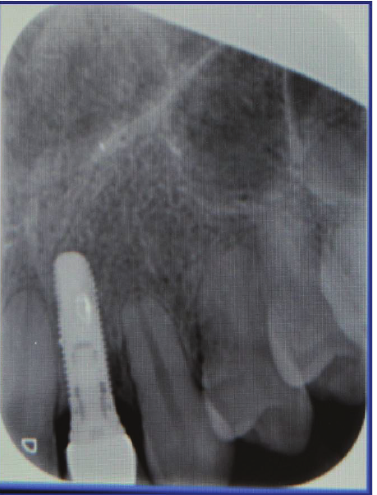
Figure 17: Radiographic control after one year in site to the